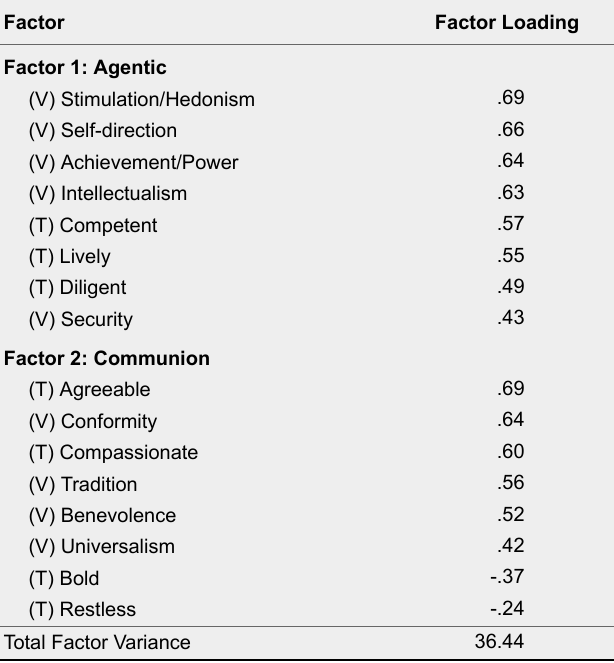
Second Order Factor Analysis for Value and Trait